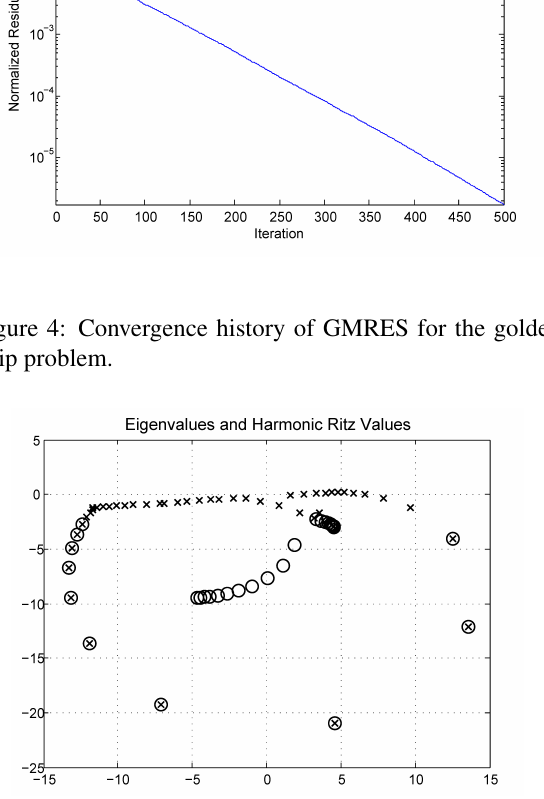
Figure 2: Line source located next to a golden strip.